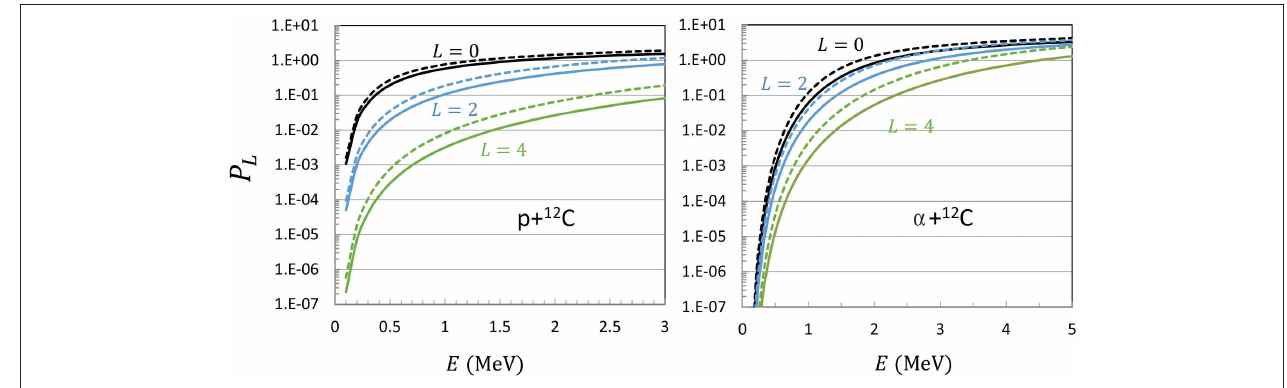
FIGURE 1 | Penetration factor (14) for the p+ 12 C (left) and α + 12 C (right) systems. Solid and dashed lines correspond to a = 5 fm and a = 6 fm, respectively.